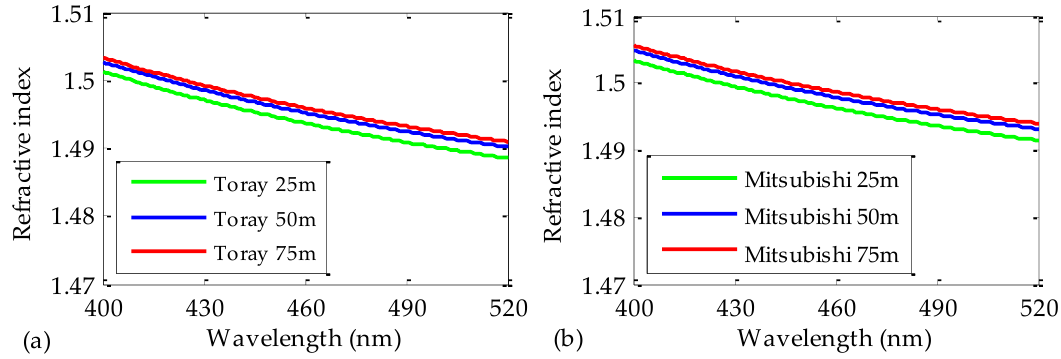
Figure 6. Refractive indices obtained for POFs made by Toray ( a ) and by Mitsubishi ( b ). Three different lengths of fiber have been employed for each manufacturer: 25 m (green lines), 50 m (blue lines), and 75 m (red lines).